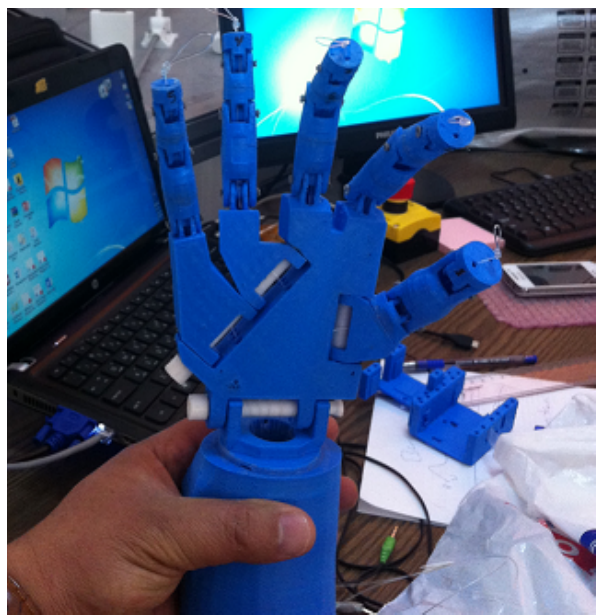
Figure 1. Robotic hand after 3D printing and